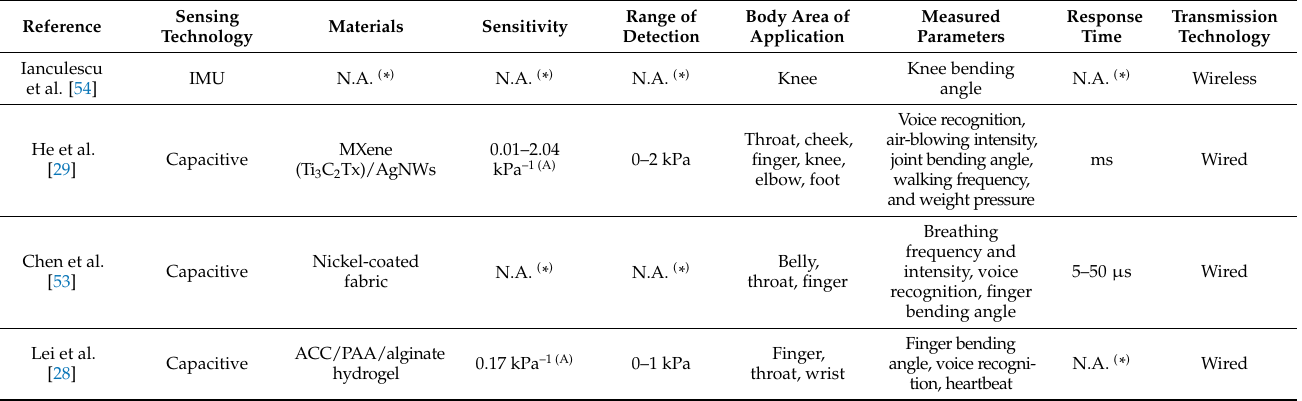
Table 4. Specification comparison of analyzed rehabilitation monitoring